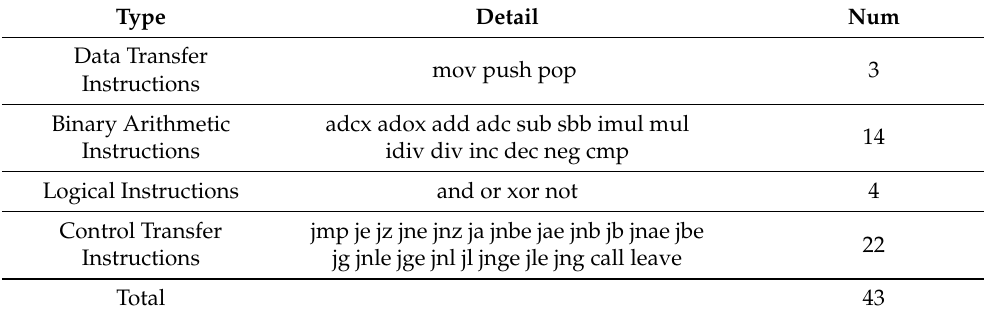
Table 2. Instruction